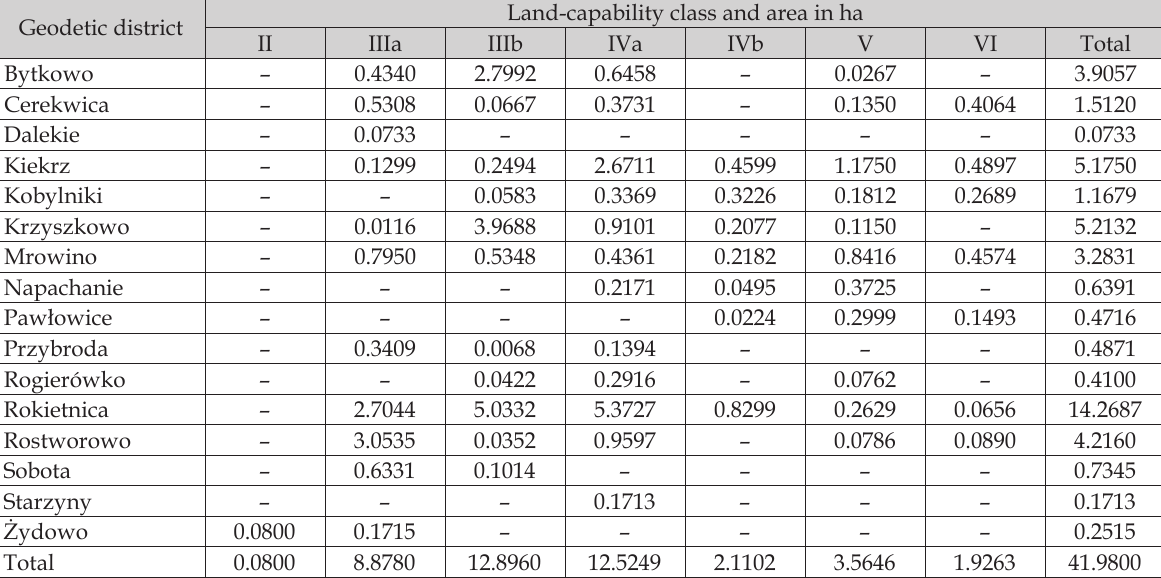
Table 4. land-capability classes of farmland on built-up housing lots in Rokietnica commune, 2014. Geodetic